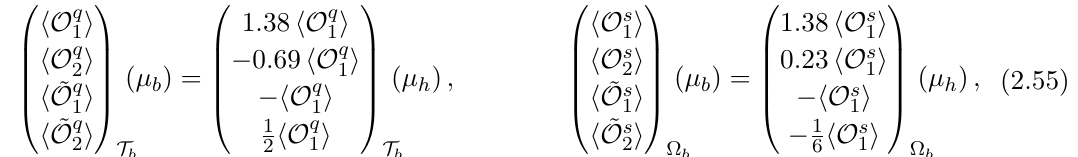
i B ≡ hB|O q |Bi / (2 M B ) . The first errors are obtained by varying the i i